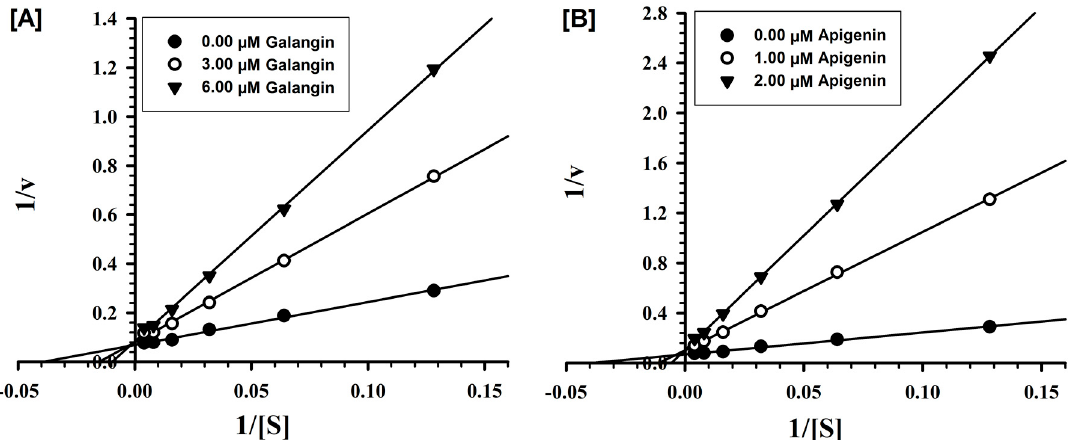
Figure 3. Kinetic characteristics of inhibition of recombinant human MAO-B with [ A ] galangin and [ B ] apigenin; V = nmoles/min/mg protein and S = substrate kynuramine concentration ( μ